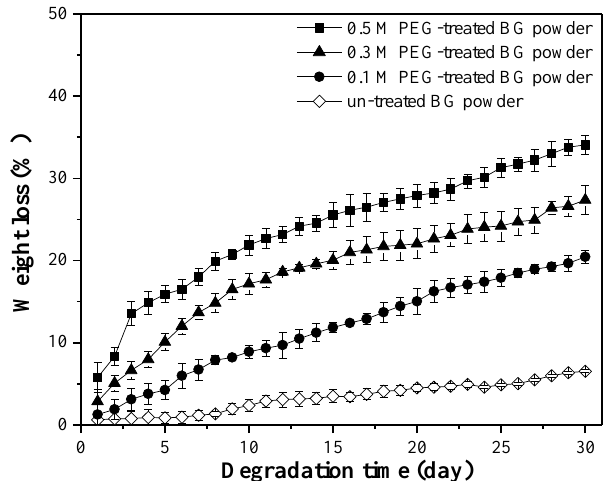
Figure 8. Weight loss of un-treated, 0.1 M, 0.3 M, and 0.5 M PEG-treated BG powders in SBF solution as a function of time.